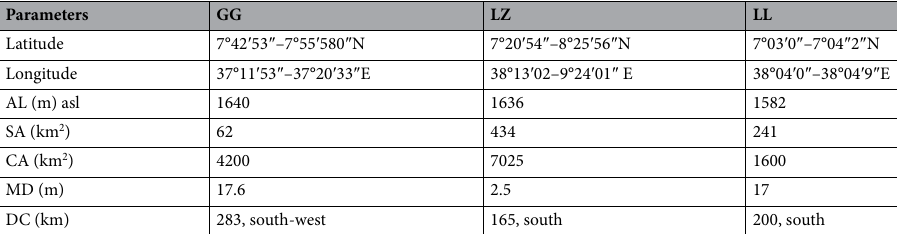
Table 5. Geographic description of the three Ethiopian lakes in this study. GG: Gilgel Gibe; LZ: Lake Ziway; LL: Lake Langano; CA = catchment area; SA = surface area; DC = distance from the capital; AL = altitude; MD = mean